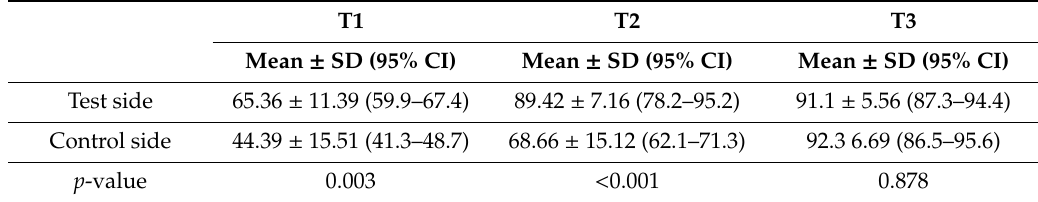
Table 2. Percentage of leveling and alignment improvement (days). Results are expressed as mean ± SD. A p < 0.05 was considered statistically significant. Compared to the control side, the test side showed a significant reduced overall time needed for space closure ( p < 0.001).